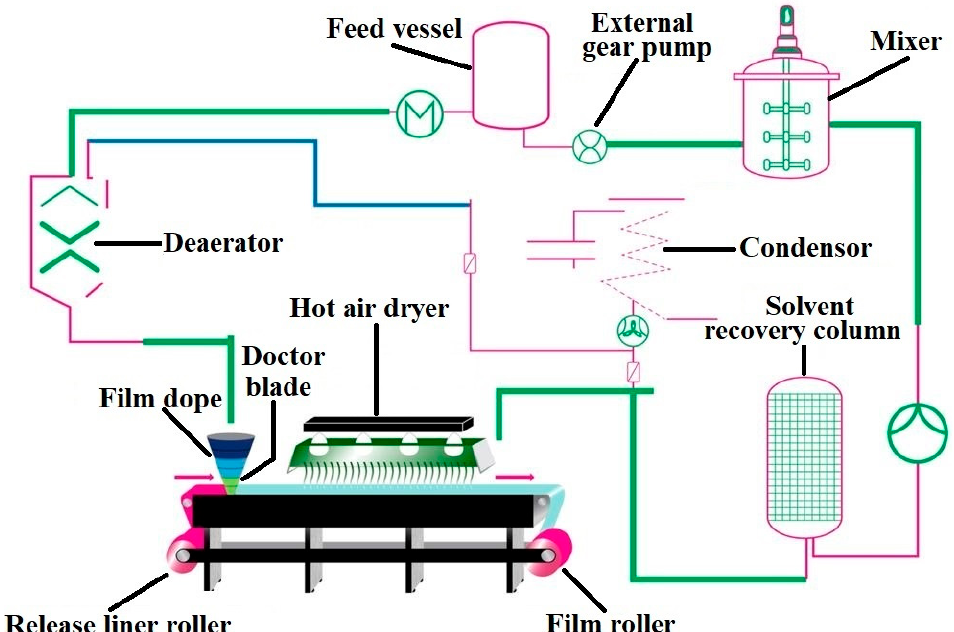
Figure 6. Flow chart illustrating the various processes typically involved in buccal film manufacturing based on solvent casting technique.